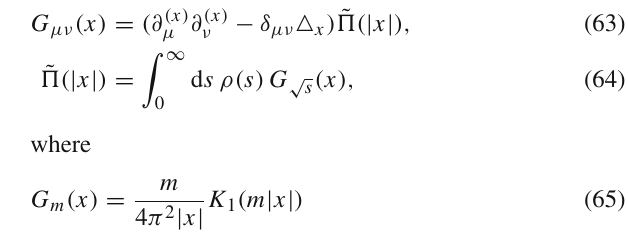
Fig. 1 The weight functions f 1 ( z ) and f 2 ( z ) needed to calculate a hvp μ using Eqs. (19, 33, 43, 62, 61). In the calculation of a hvp μ , the argument oftheweightfunctionsis ( m μ | x | ) ,sothat z = 1corresponds to1.87fm. and lim z → 0 f 1 ( z )/ z 4 = 1 ; see Note that lim z → 0 f 1 ( z )/ z 4 = 7 9216 2304 Eqs. (32) and